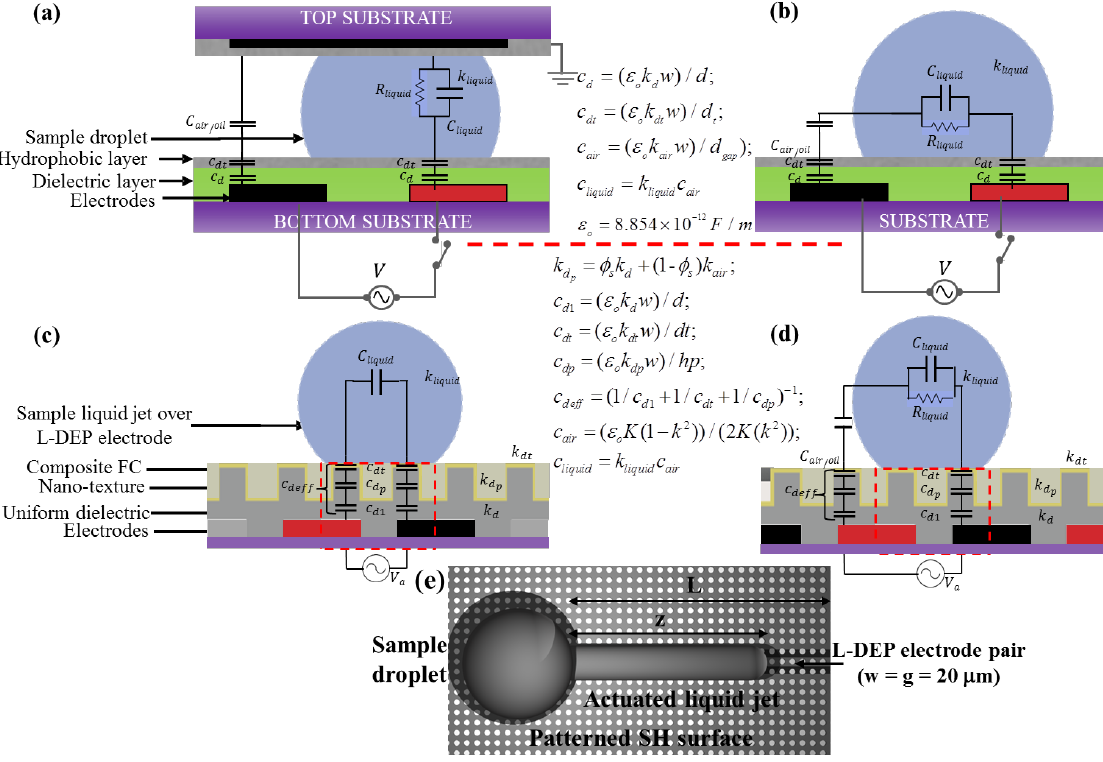
Figure 2. Electromechanical RC actuation model for: ( a ) dual surface, DMF droplet electro-actuation; ( b ) a single surface droplet electro-actuation; ( c ) L-DEP liquid jet actuation over coplanar electrodes and a superhydrophobic surface; ( d ) D-DEP actuation over a nano-textured superhydrophobic surface; and ( e ) schematic top view of an actuated liquid jet (L-DEP